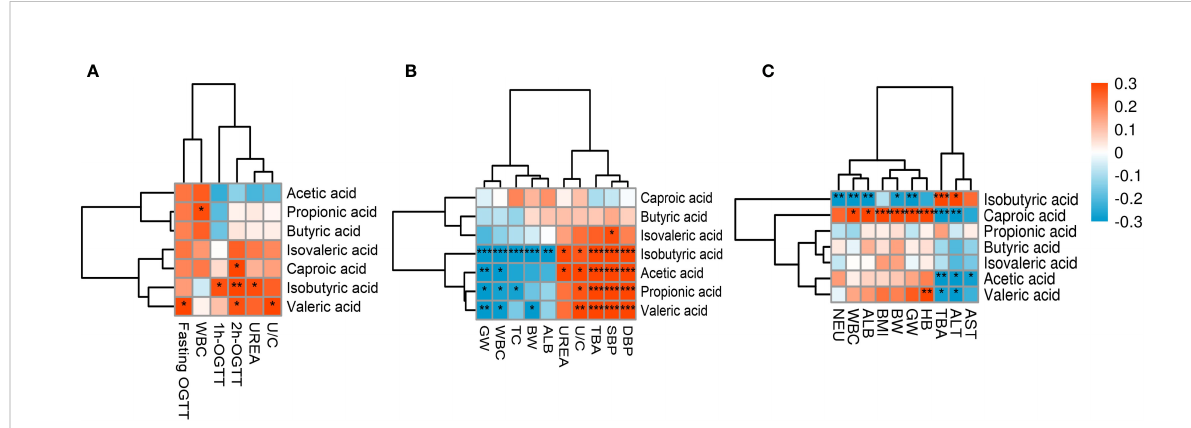
FIGURE 5 Heat map of correlations between SCFAs and clinical indicators. Red and blue squares represent positive and negative correlations, respectively. Statistical signi fi cance is indicated on the square (*P < 0.05; **P < 0.01; ***P < 0.001). WBC, White blood cells; UREA, Urea; U/C, Urea/creatinine ratio; GW, Gestational week; TC, Total cholesterol; BW, Birth weight; ALB, Albumin; TBA, Total bile acid; SBP, Systolic blood pressure; DBP,Diastolic blood pressure; NEU, Neutrophil percentage; BMI, Prenatal BMI; HB, Hemoglobin; ALT,Alanine aminotransferase; AST, Aspartate aminotransferase.